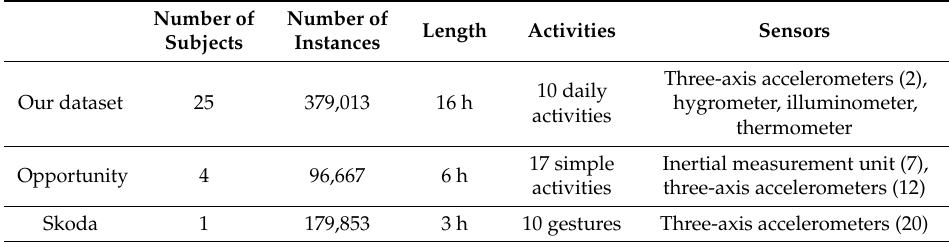
Table 8. Comparison of our dataset with another open dataset for